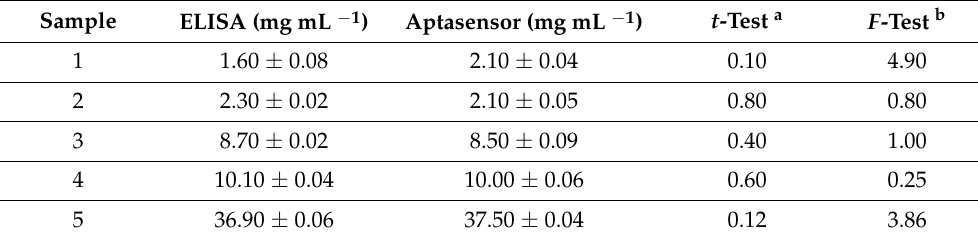
Table 4. GA measurements obtained from three repeated analyses by proposed aptasensor and ELISA kit for five clinical serum samples.